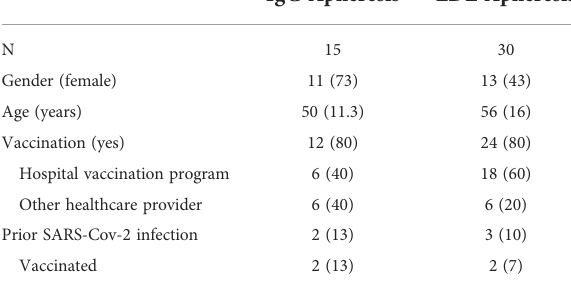
TABLE 1 Details of the Vienna apheresis cohort [count (percent), mean (standard deviation)] as of June